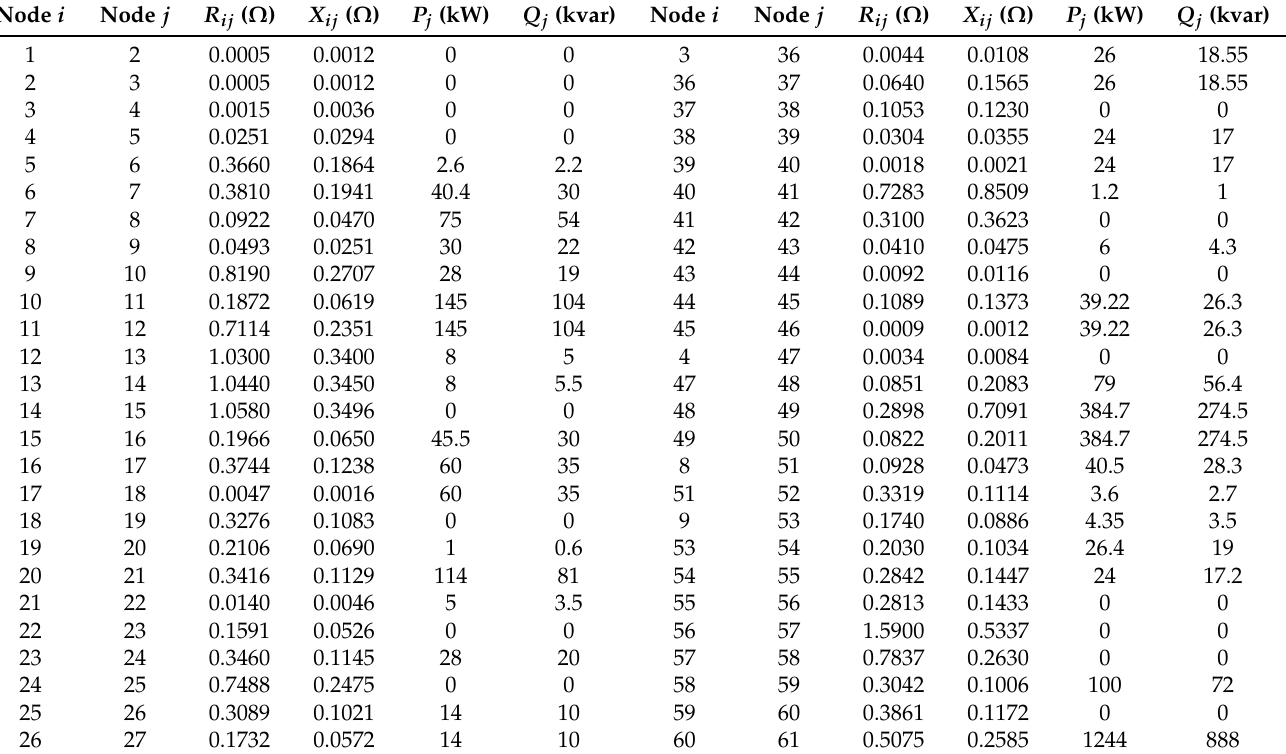
Table 2. Electrical parameters of the IEEE 69-node test